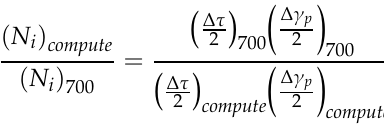
∆(cid:3082) (cid:3291) ∆ γ ). p (cid:2870) 2